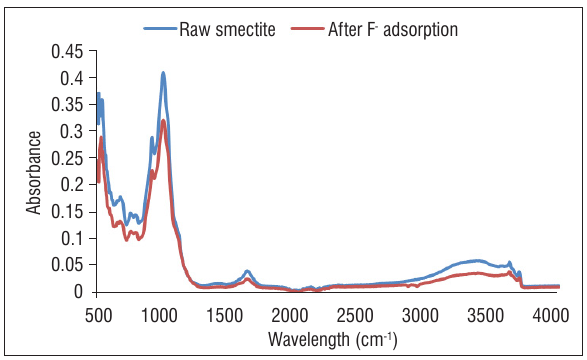
Figure 3: Fourier transform infrared spectroscopy spectra for raw and fluoride-loaded smectite-rich clay soil.